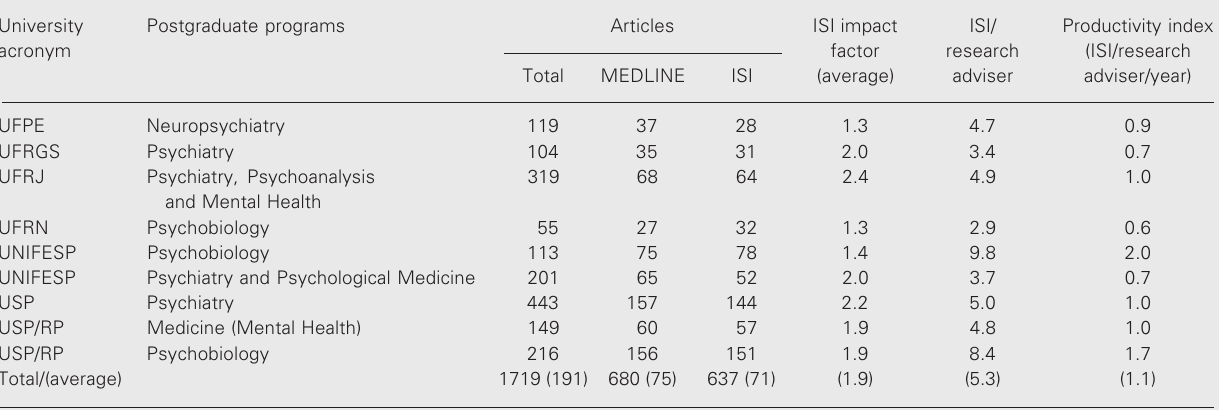
Table 3. Number of articles published in Psychiatry and related areas covered by MEDLINE and ISI and related to research adviser productivity during